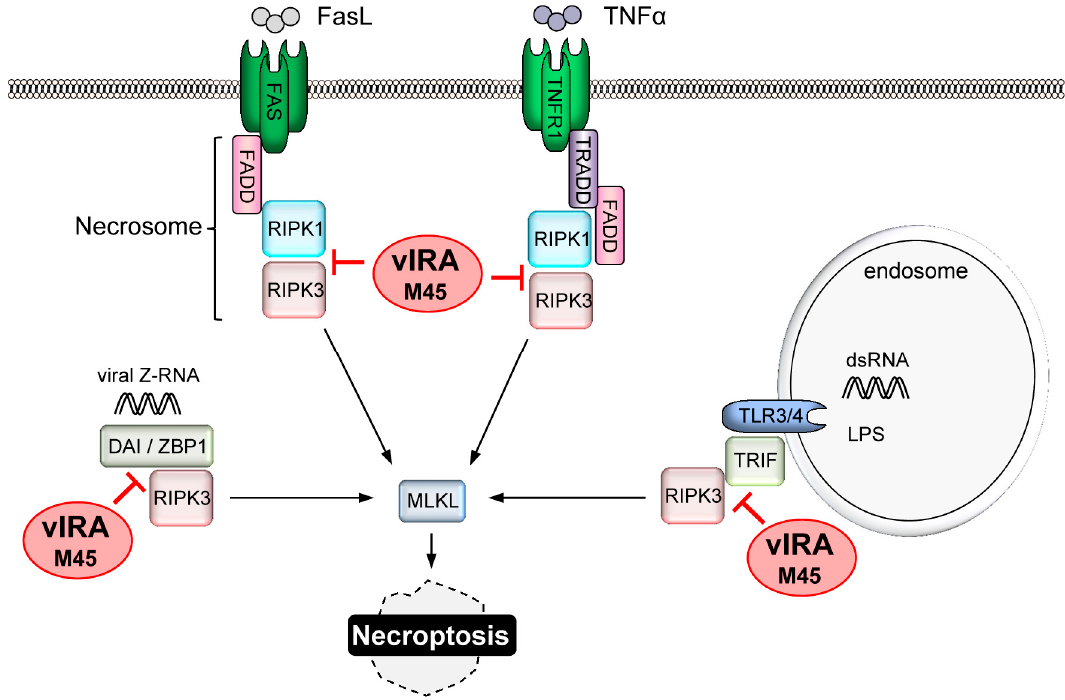
Figure 2. Inhibition of necroptosis by MCMV. Induction of programmed necrosis (necroptosis) involves activation of RIPK3 and mixed lineage kinase domain-like (MLKL). The viral inhibitor of RIP activation (vIRA), encoded by the MCMV M45 gene, contains a RIP homotypic interaction motif (RHIM) and inhibits RHIM-dependent activation of RIPK3 by RIPK1, DAI/ZBP1, or TRIF. Death